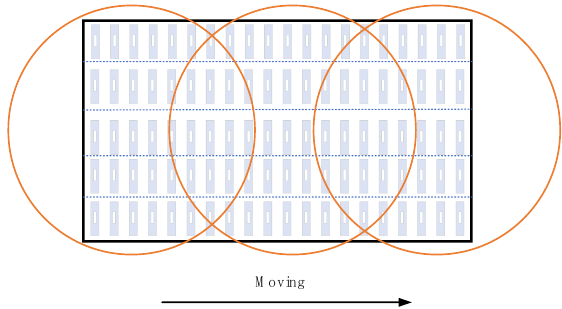
Figure 4. The change in the identification range.